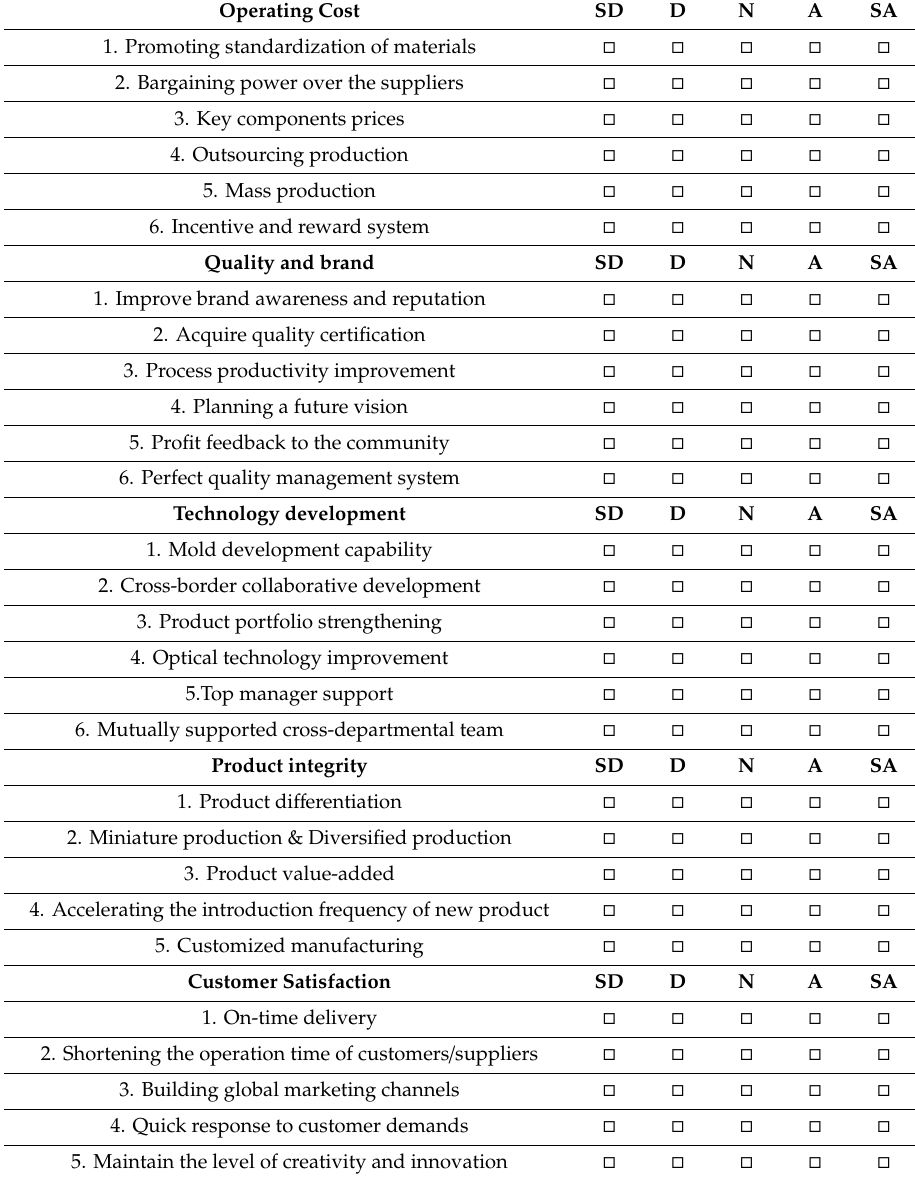
Table A2. The questionnaire used in this